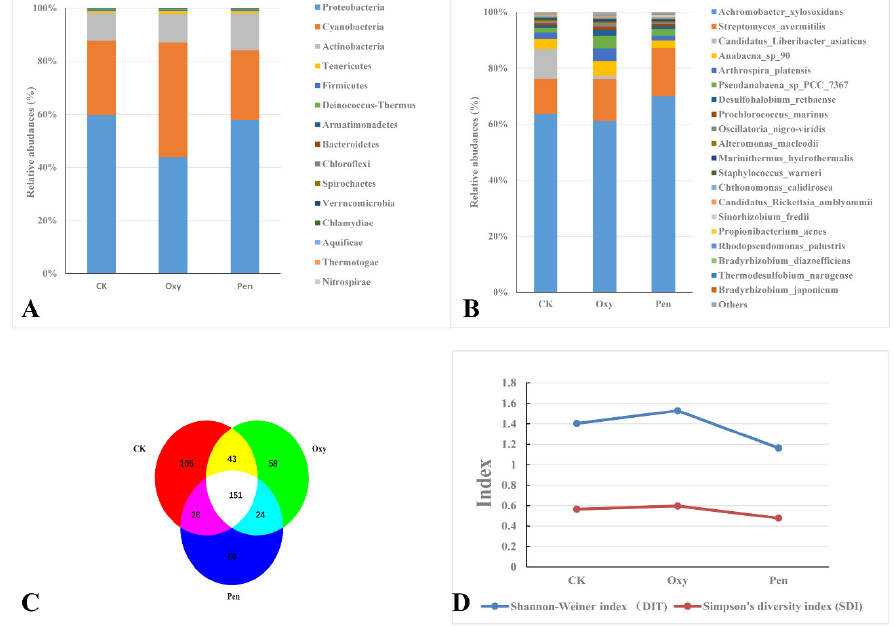
Figure 2. Bacterial species present after antibiotic treatments of HLB-a ff ected citrus plants. Taxonomic abundance of microbial community at the ( A ) phyla and ( B ) species rank in HLB-a ff ected citrus treated with oxytetracycline (Oxy) or penicillin (Pen). ( C ) Venn diagram representing bacterial species in the endophytic microbial community in HLB-a ff ected citrus treated with tap water (CK), oxytetracycline (Oxy), or penicillin (Pen). ( D ). Simpson’s diversity index (SDI) and Shannon–Weiner index (DIT) of the endophytic microbial community in HLB-a ff ected citrus treated with tap water (CK), oxytetracycline (Oxy), or penicillin (Pen).